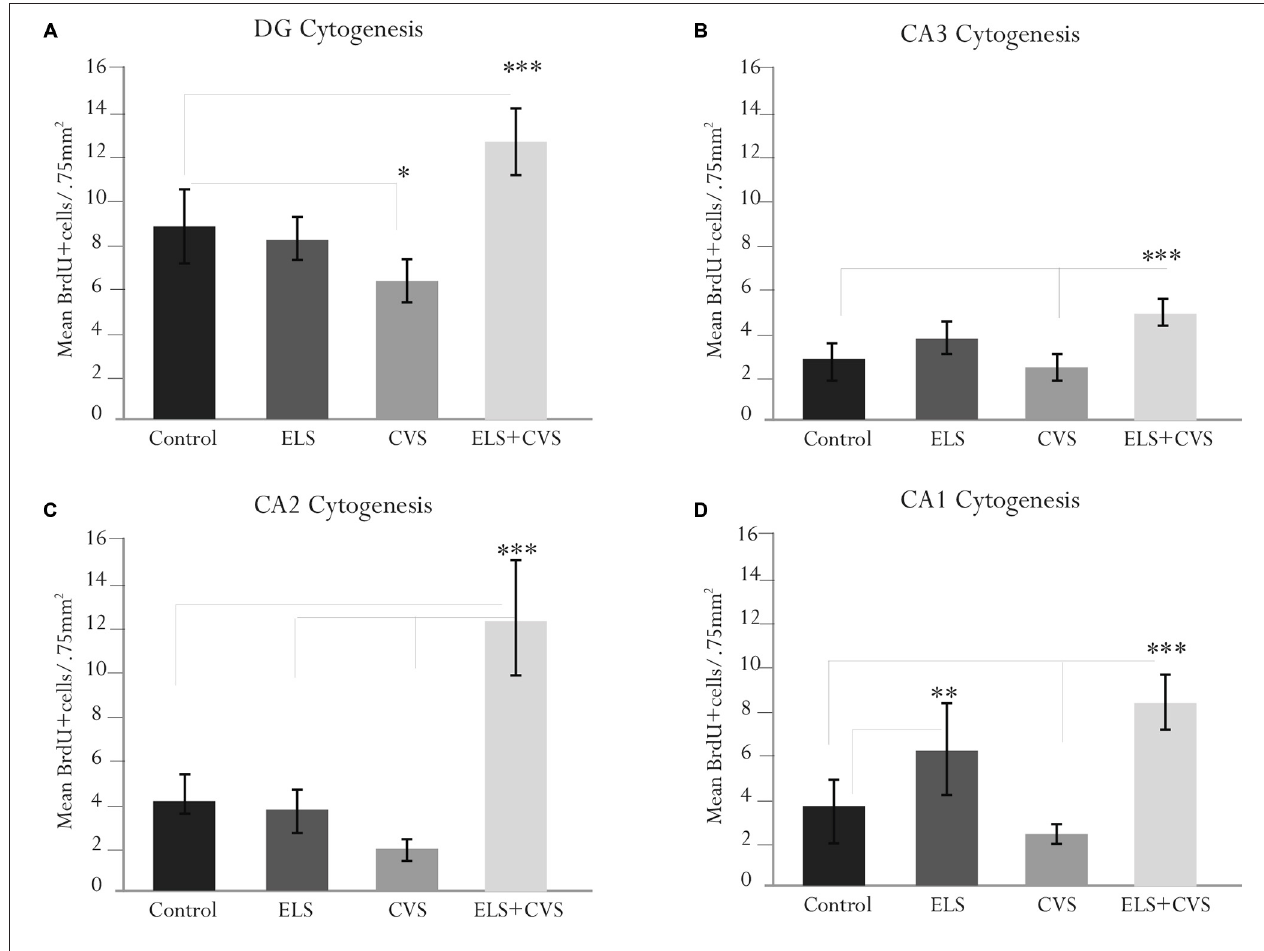
0.001), CA3 ( ∗∗∗ p < 0.001), CA2 ( ∗∗∗ p < 0.001), and CA1 ( ∗∗∗ p < 0.001). The CVS-exposed rats exhibited a decreased number of 5 (cid:48) Bromodeoxyuridine (BrdU+) cells in the DG ( ∗ p < 0.05). The ELS-exposed rats exhibited an increased number of BrdU+ cells in the CA1 region ( ∗∗ p <